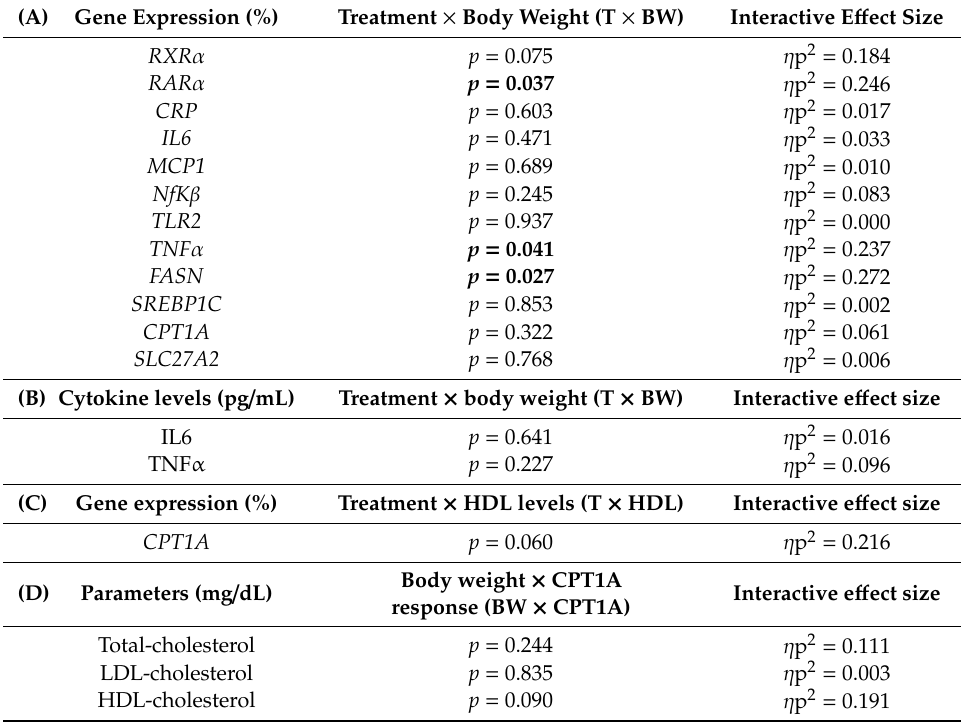
Table 2. p -Values and e ff ect size for the interactive e ff ects analyzed by two-way